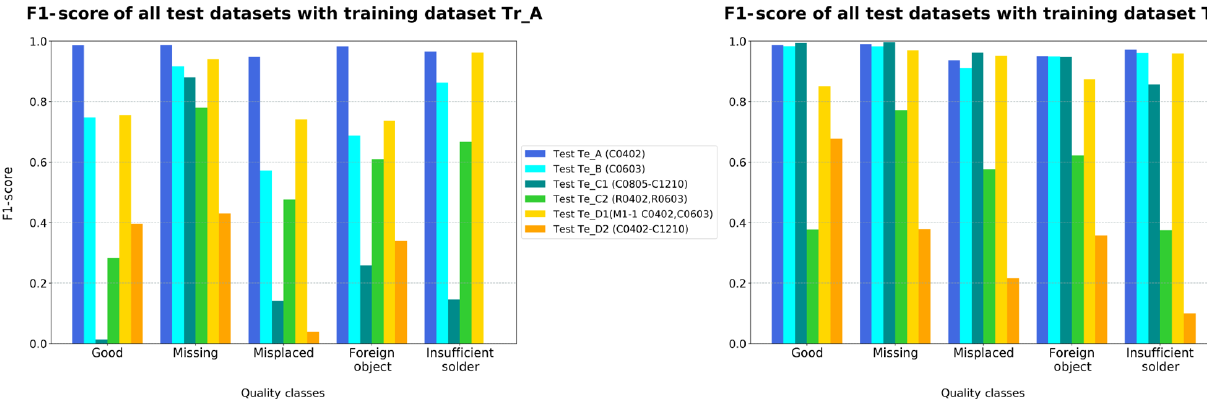
Figure 7. F1-Score of all test datasets with training datasets Tr_A and Tr_D.